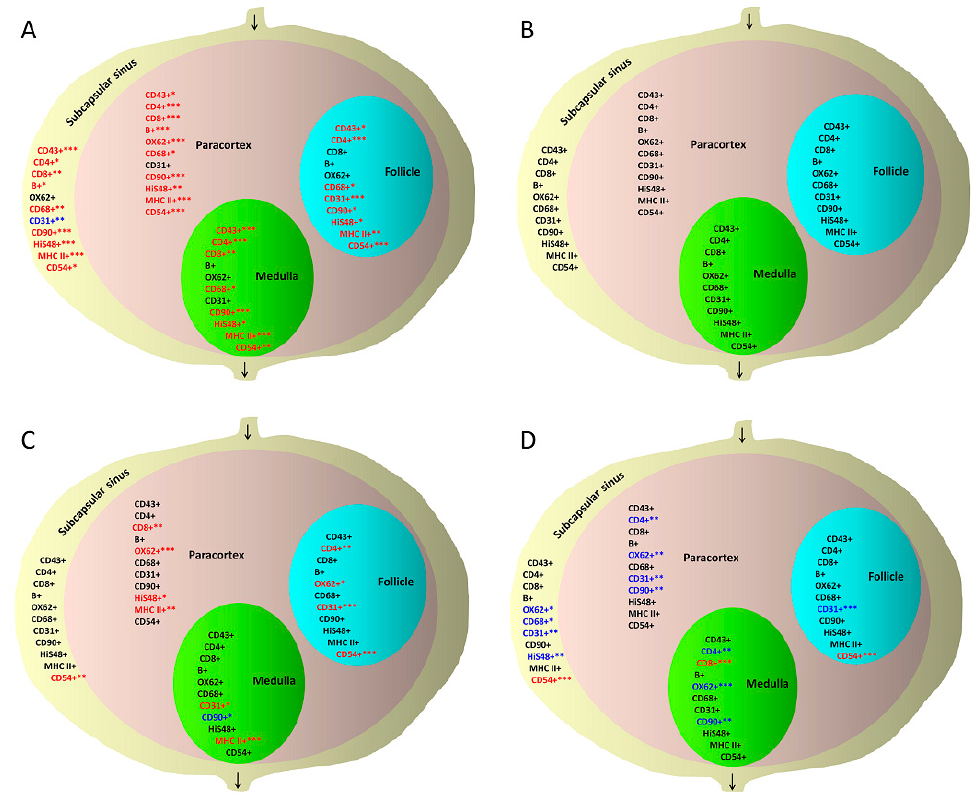
Figure 4. Quantitative changes in the surface of rat popliteal lymph node zones covered with immune cell subpopulations following S. epidermidis skin infection, assessed using the Microimage program ( n = 8, 16 nodes). ( A ) Nodes after the initial massive skin infection with S. epidermidis with early evaluation (day 8) compared with controls administered 0.9% NaCl. ( B ) Nodes after the initial massive infection with late evaluation (day 28) compared with controls administered 0.9% NaCl. ( C ) Nodes after re-infection with S. epidermidis (evaluation on day 29) compared with the initial infection with late evaluation (day 28). ( D ) Nodes after re-infection compared with the initial infection with early evaluation (day 8). CD43+: T lymphocytes; CD4+: T helper lymphocytes, monocytes; CD8+: T cytotoxic lymphocytes; B+: B lymphocytes; OX62+: dendritic cells; CD68+: macrophages, monocytes; CD31+: PECAM-1, endothelial cells; CD90+: stem cells, thymocytes, immature B cells; HiS48+: granulocytes; MHC class II+: activated antigen-presenting cells; CD54+: dendritic, endothelial, ICAM-1+ cells. Red: increase in surface area of cells stained positive for the given antigen; blue: reduction in surface area of cells expressing the antigen of interest; black: no quantitative change. * p < 0.05; ** p < 0.01; *** p <